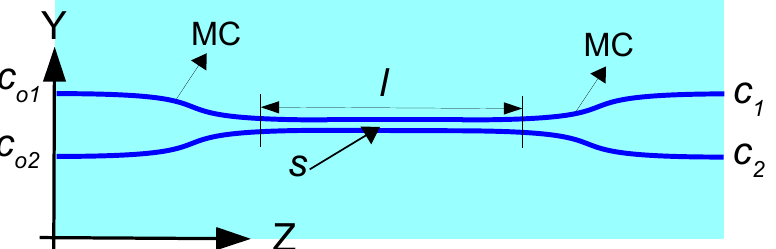
Figure 15. Sketch of a directional coupler belonging to the series of directional couplers fabricated. The main parameters are indicated: separation s between channel guides and length l of the guides from after and up to before the Minford curves